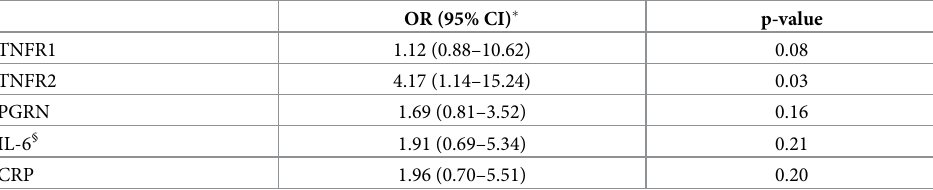
Table 6. Results of multivariate logistic regression analysis of the inflammatory markers for